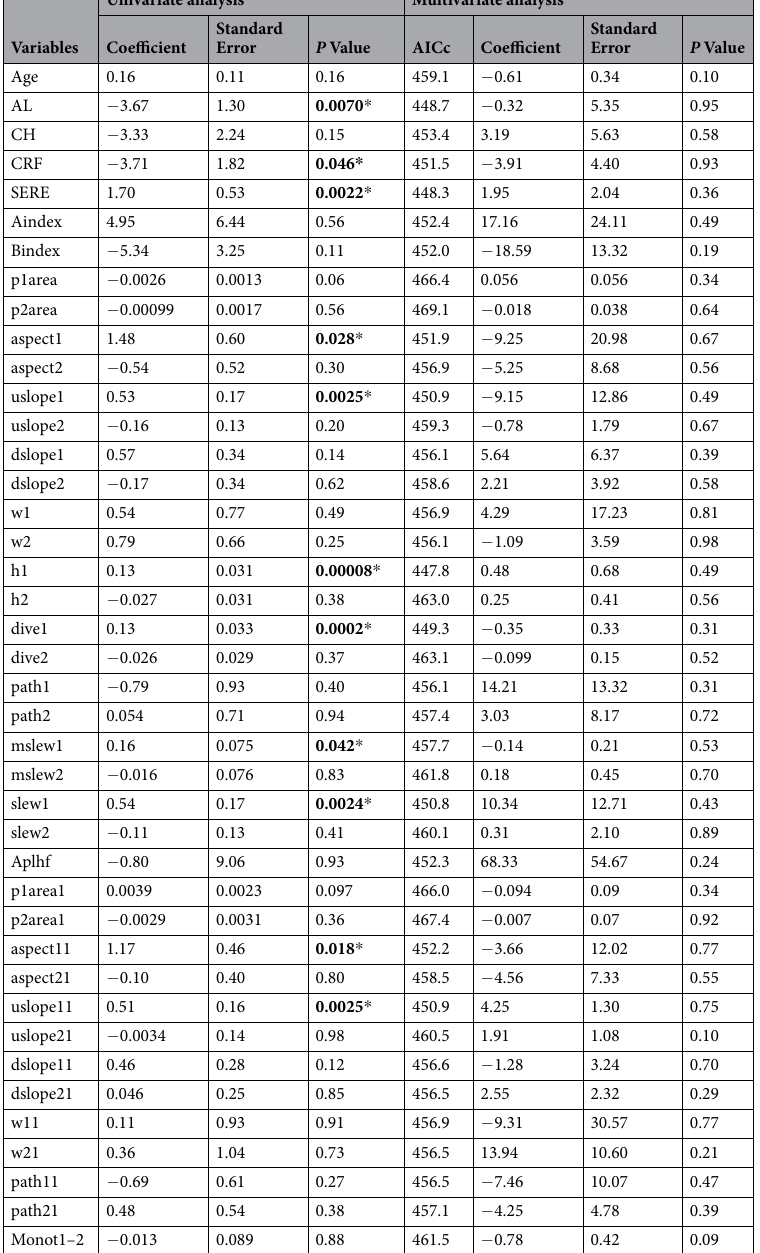
Table 3. Results of univariate and multivariate linear regression between PRAA and the values of age, AL, CH, CRF, SERE, and ORA waveform parameters. * P value < 0.05, AL: Axial length; CH: corneal hysteresis; CRF: corneal resistance factor; SERE: spherical equivalent refractive